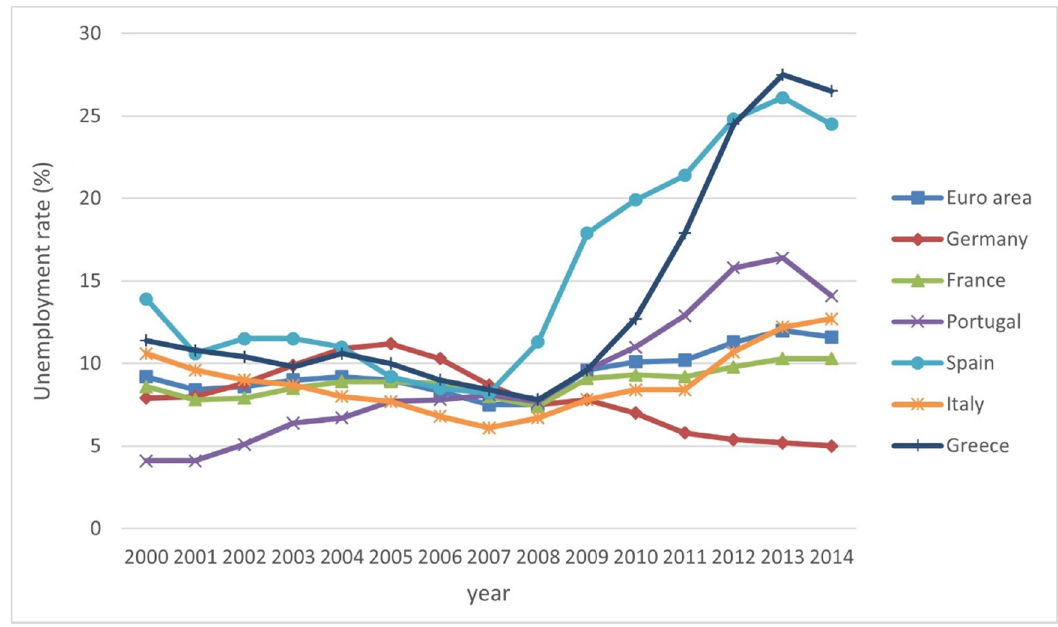
Figure 2: Evolution of unemployment rates. Source: AMECO - EU.